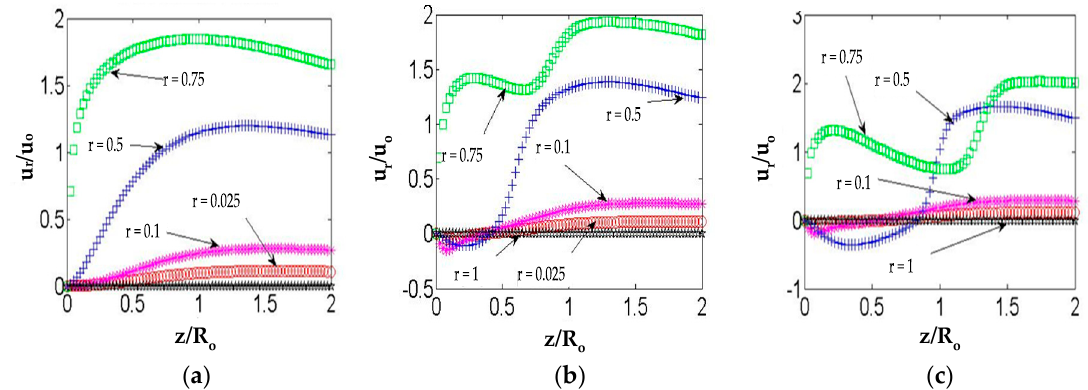
Figure 11. Development of the radial velocity z-axis distribution at P e = 0 ( a ), P e = 0.5 ( b ) and P e = 1 ( c ).